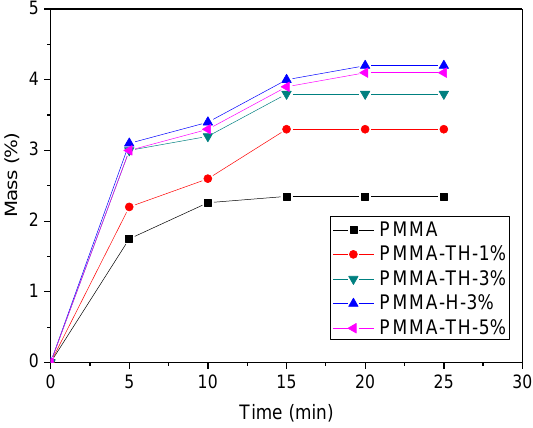
Figure 9. Moisture absorption curves of PMMA/reactive halloysite nanocomposite films.